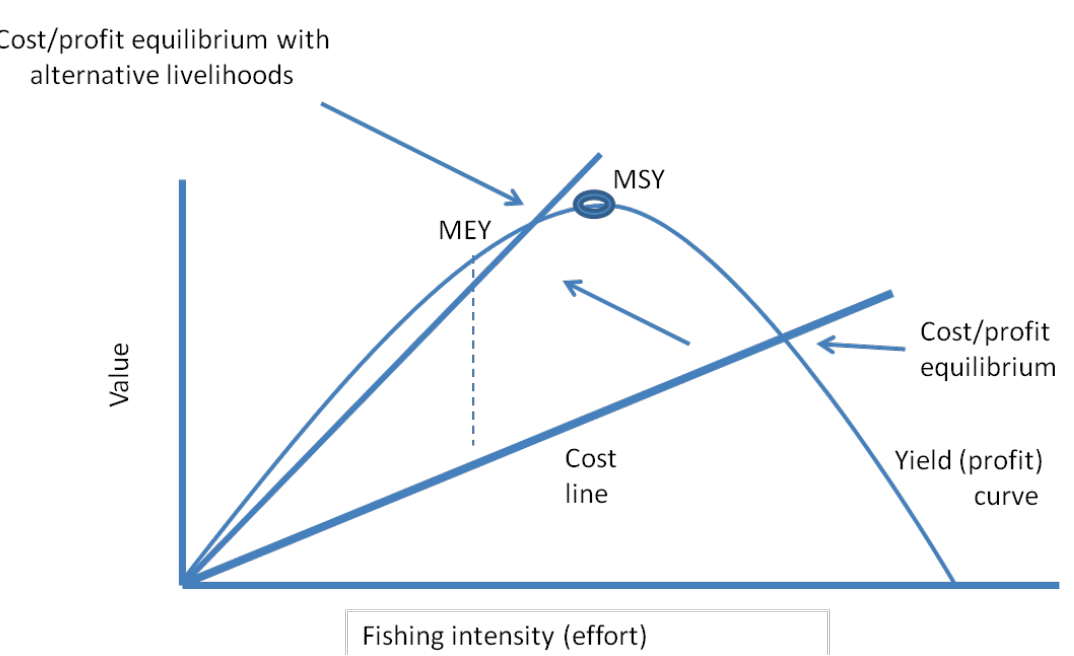
Figure 3. Fixed-price model of a harvest system. The value axis is the cost of fishing (including opportunity cost) or the value of the catch and thus proportional to the catch. MSY = Maximum Sustainable Yield, MEY = Maximum Economic Yield. Redrawn from